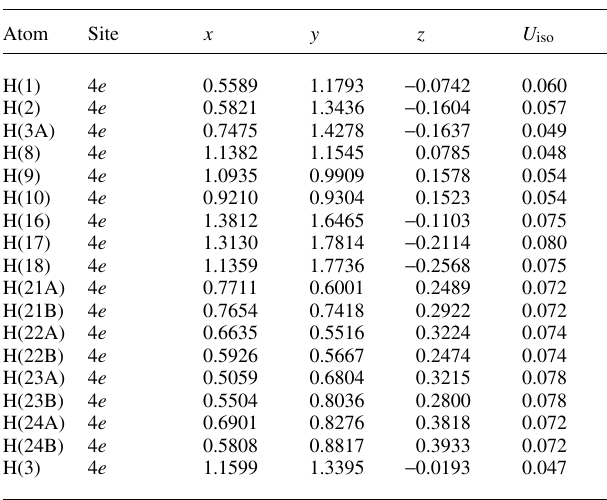
Table 2. Atomic coordinates and displacement parameters (in Å 2 ) .